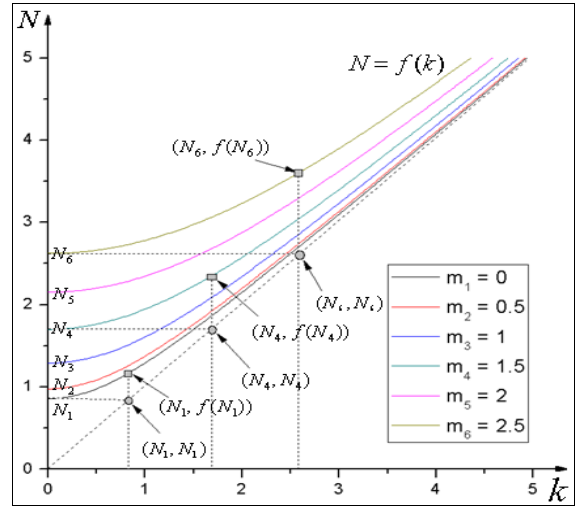
Figure 1. The rationship curve graph of N and